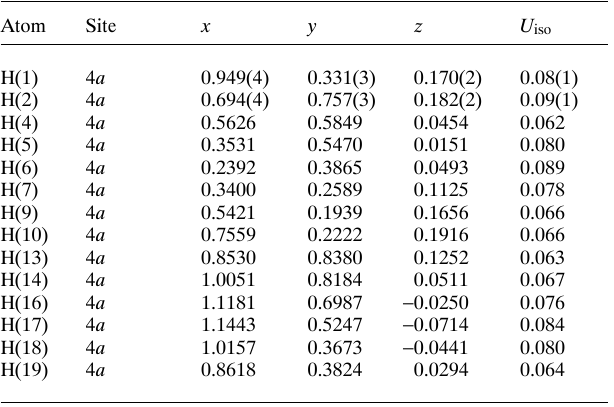
Table 2. A tomic coordin a tes a nd displ a cement p a r a meters (in Å 2 ) . Table 2. C